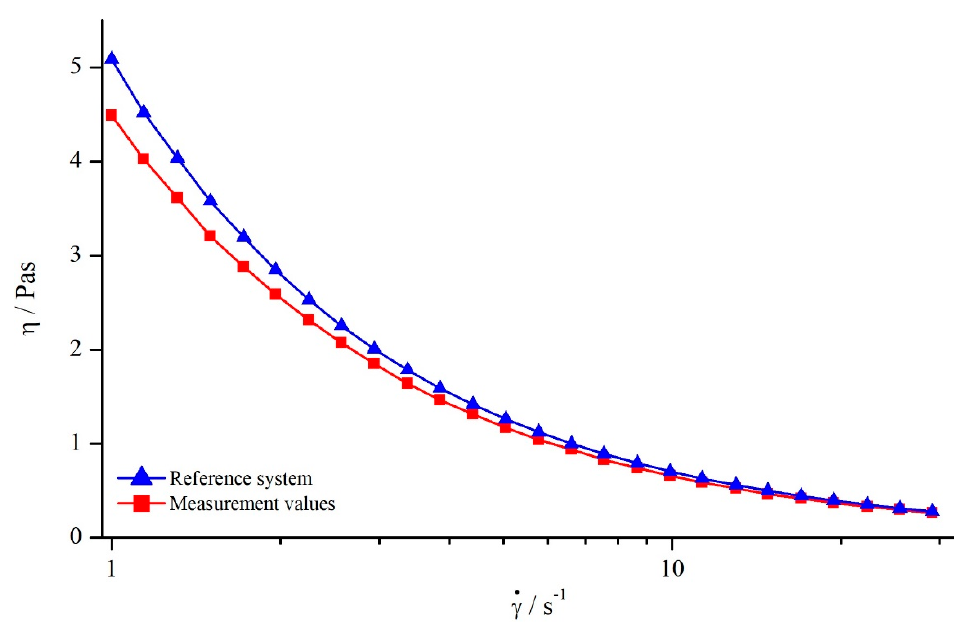
Figure 14. Comparison between viscosity values of 1 wt. % xanthan gum solution obtained for columns (system 6) and reference system at H = 1 mm.